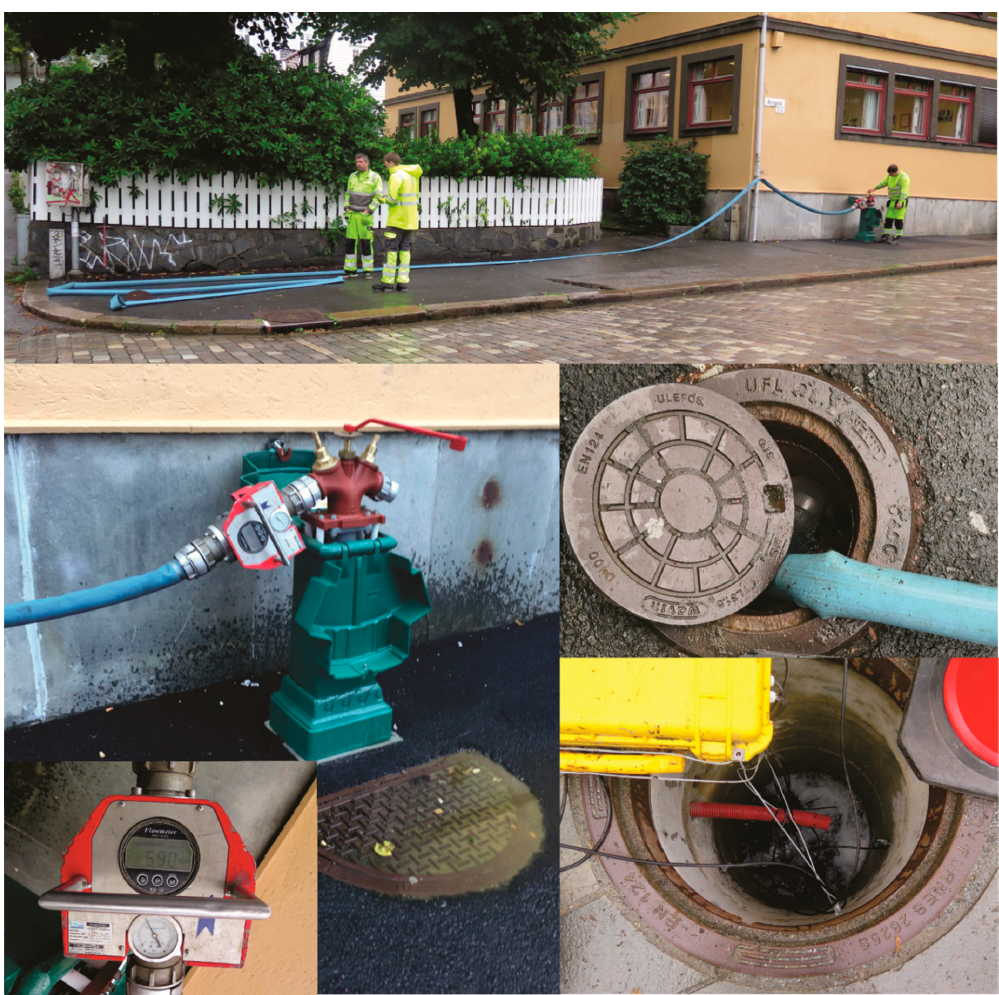
Figure 6. Description of the full-scale infiltration test at Bryggen on 6th of September 2017.